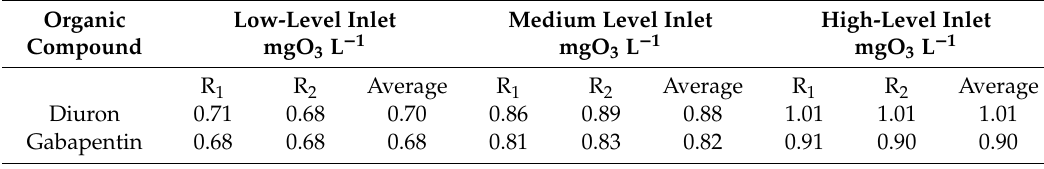
Table 3. Initial ozone concentration in the ozone treatment.